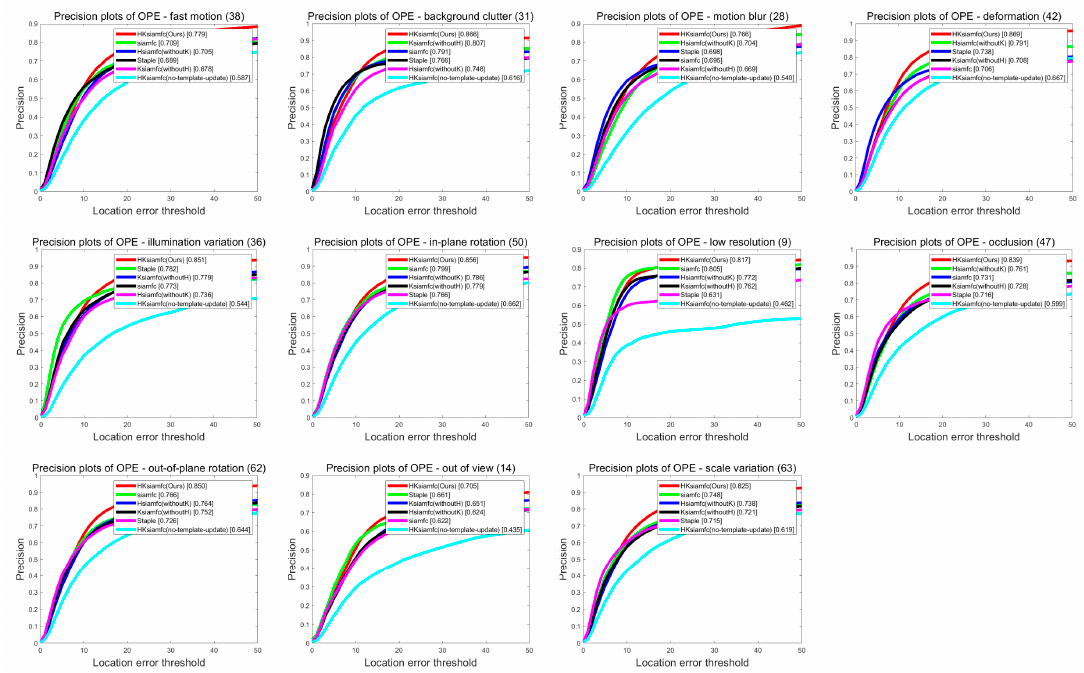
Figure 6. Comparison of HKSiamFC and five baseline trackers using precision-plot metric under the 11 tracking scenarios. This picture is best viewed on high-resolution displays.